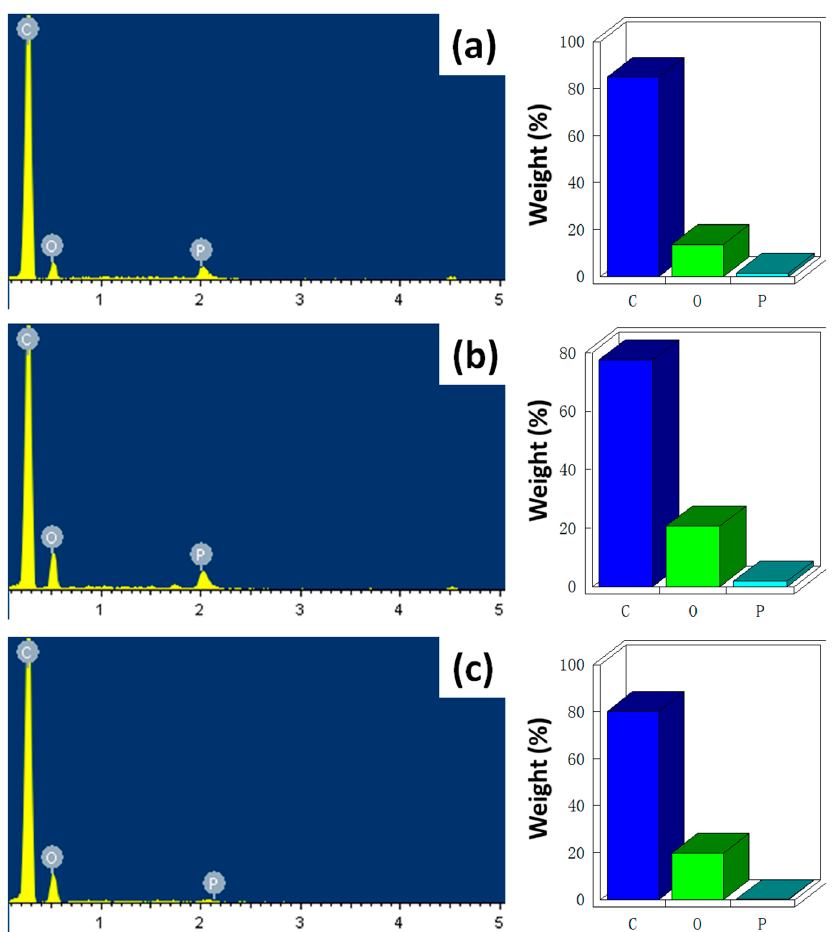
Figure 11. EDX chemical compositions of the residues after cone calorimeter tests: ( a ) PBT/DPP-A-CNT; ( b ) PBT/DPP(O)-A-CNT; and ( c ) PBT/DPP(O 3 )-A-CNT.